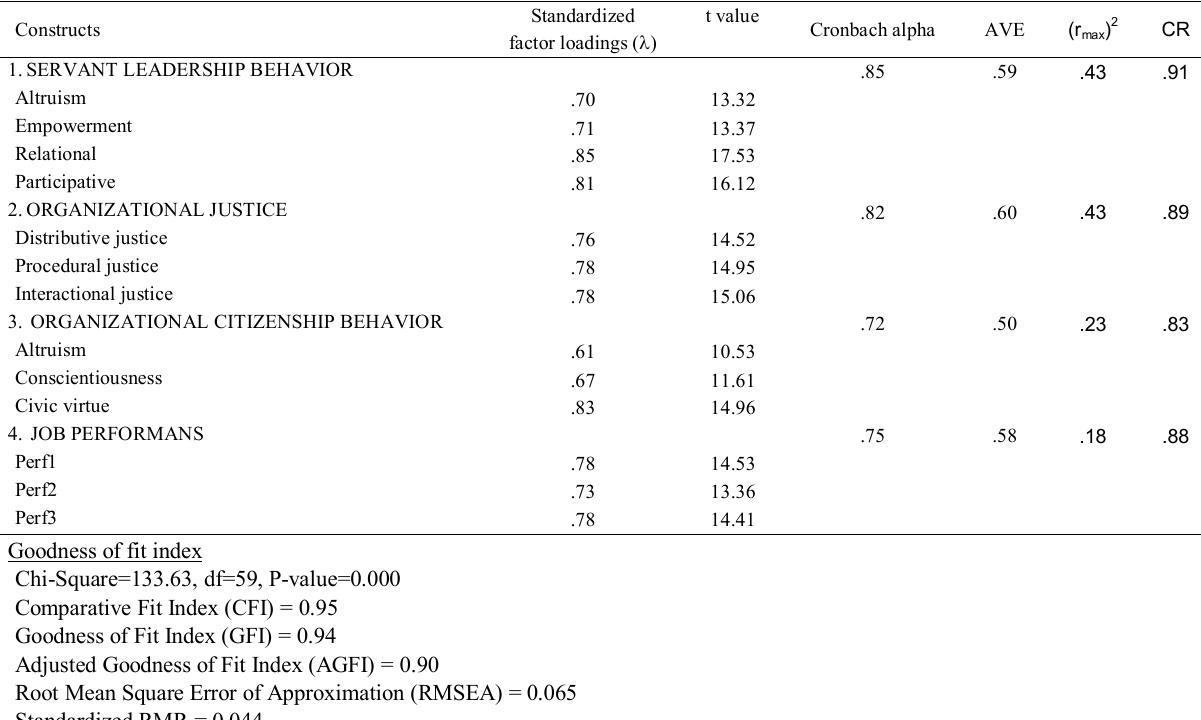
Table 1. Full measurement model results